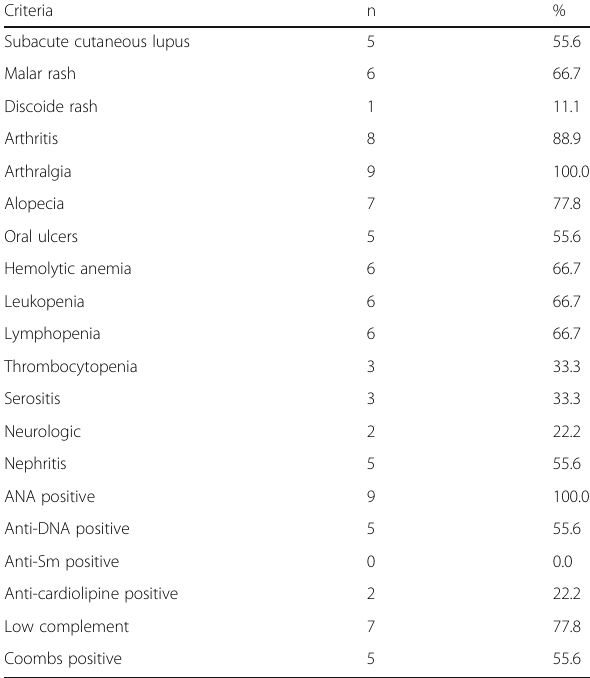
Table 1 (abstract O76). SLE criteria observed at the time of diagnosis